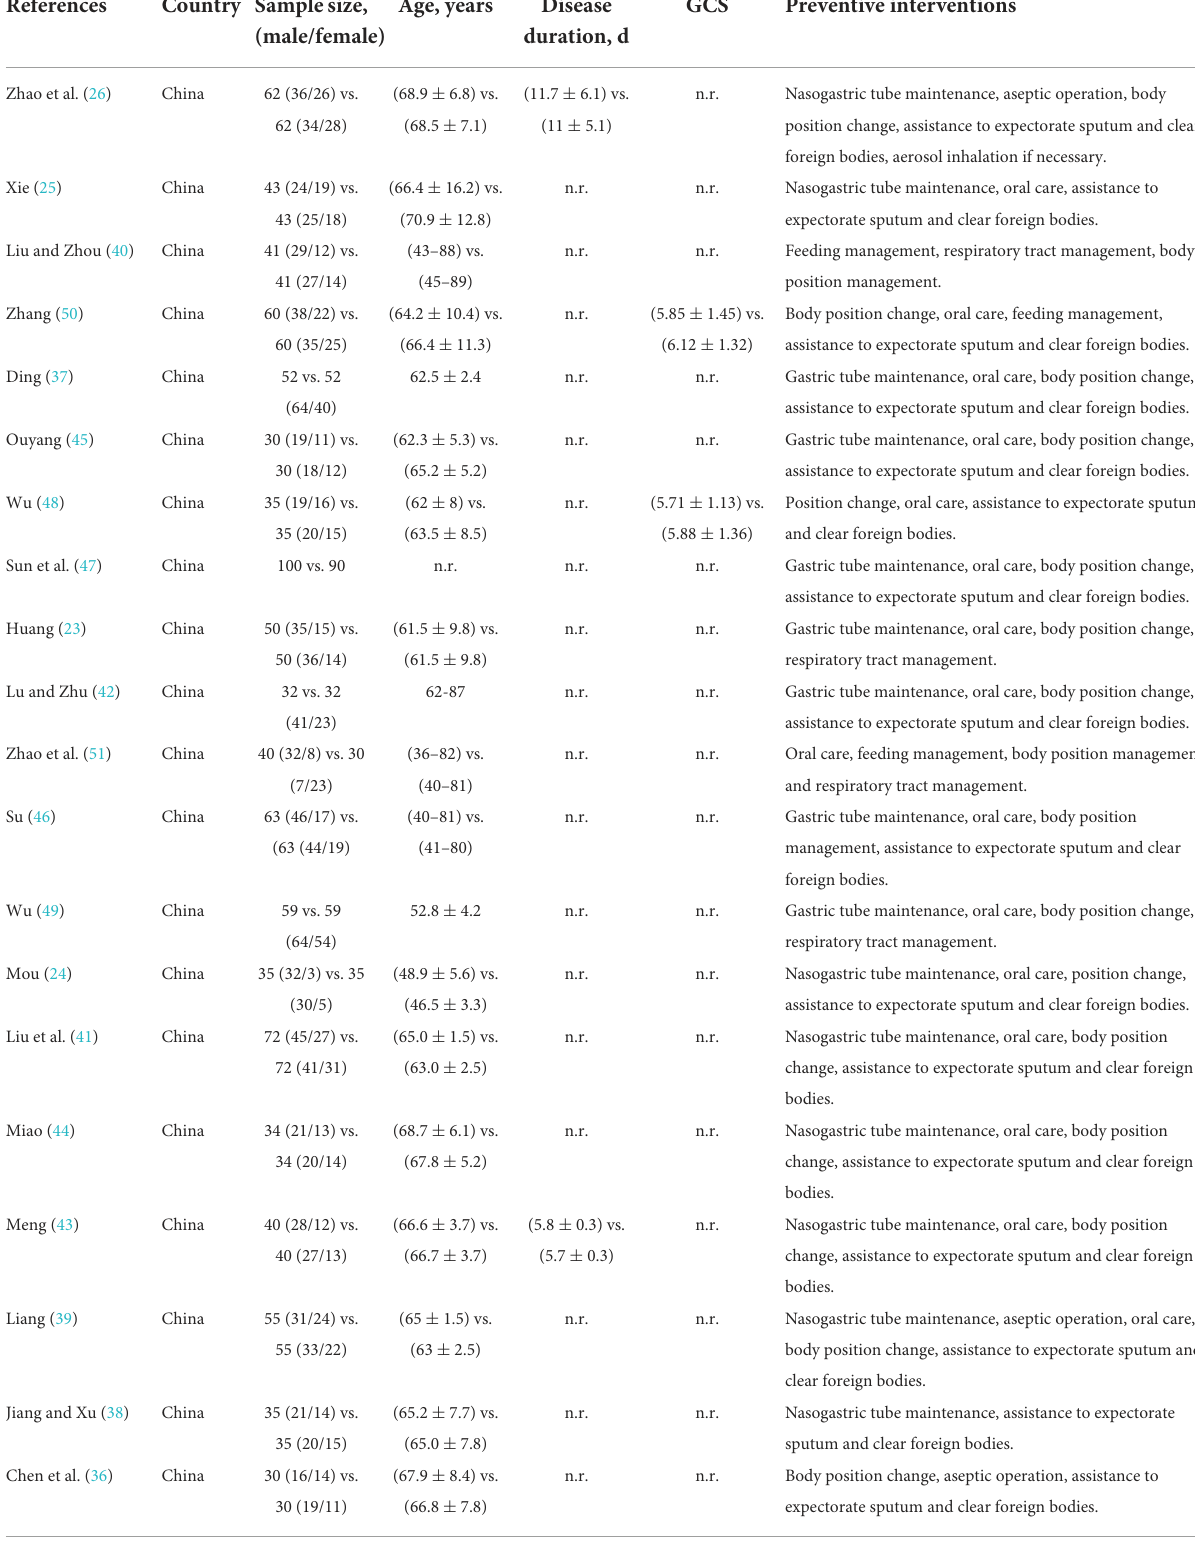
TABLE 1 Basic information of 20 eligible studies in the present